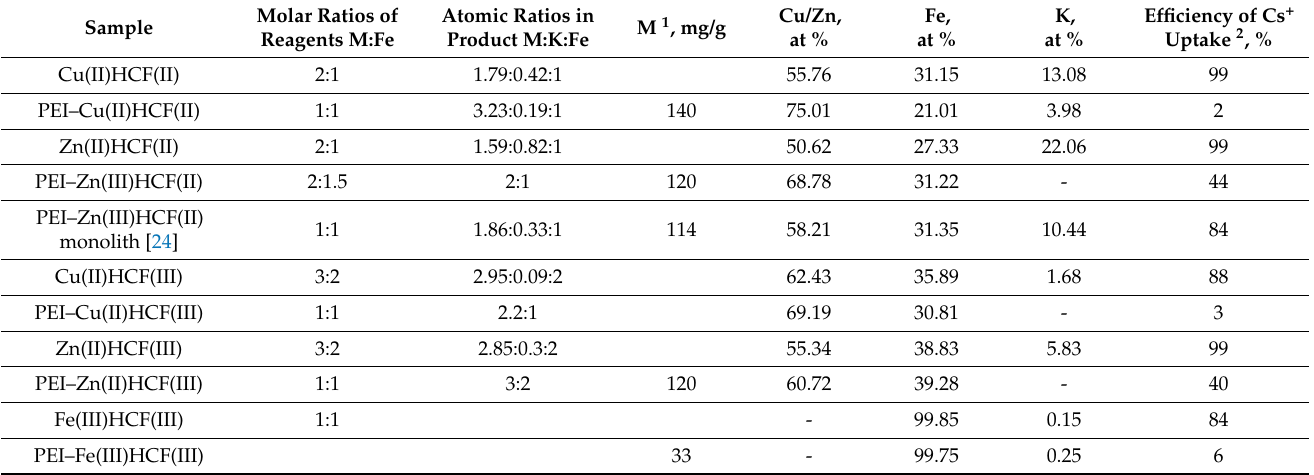
Table 1. Elemental analysis and cesium sorption efficiency and ν (CN) of crystalline hexacyanoferrates (HCF) and related PEI–HCF hybrids, M—Cu(II), Zn(II),